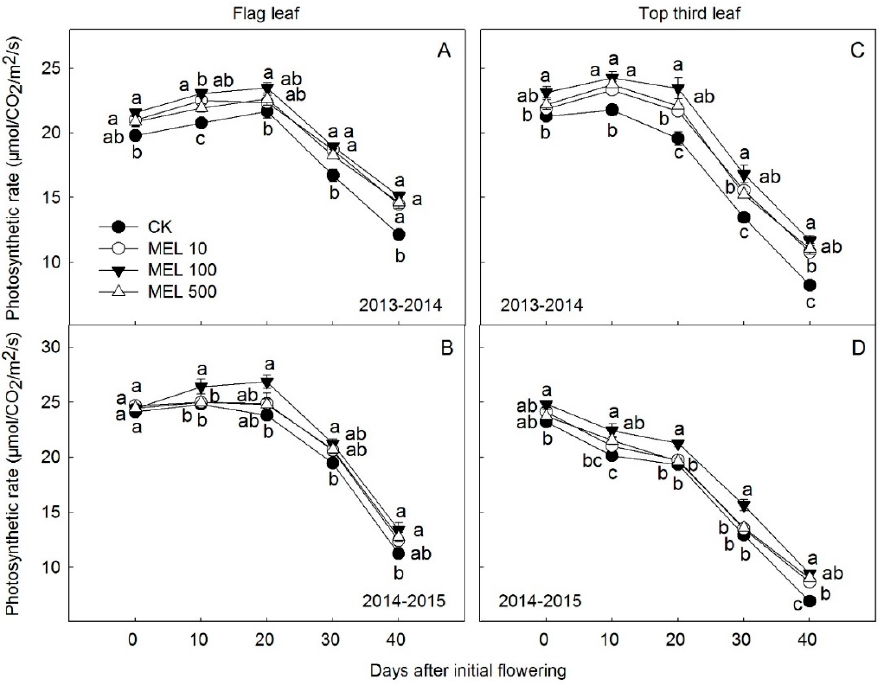
Figure 4. The effects of MEL application on photosynthetic rate after 0, 10, 20, 30 and 40 days of initial flowering. ( A , B ) are the photosynthetic rate of flag leaves in the 2013–2014 and 2014–2015 growing seasons, and ( C , D ) are for the top third leaves in two growing seasons. Values are means ± SEs of six replicates. Significant differences between different treatments on the same day of the experimental period are indicated by different letters ( p < 0.05).